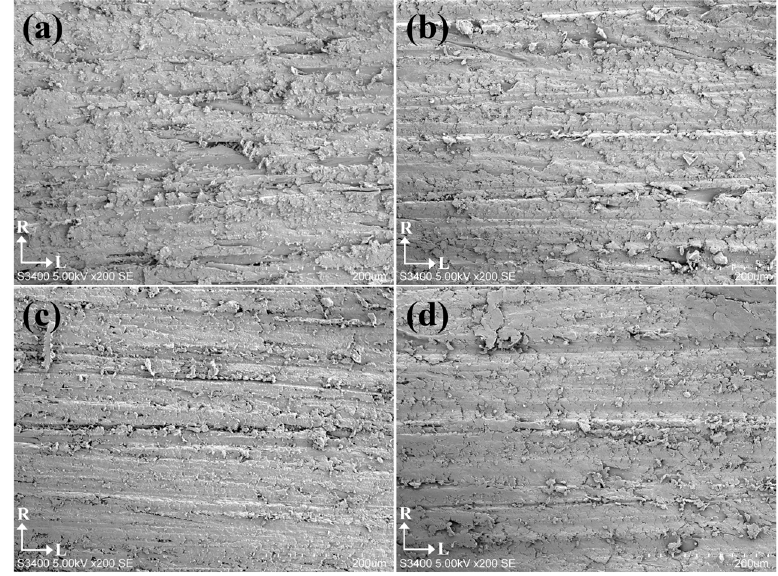
Figure 5. Surface micrographs of the sanded scrimbers with various densities: ( a ) 0.80, ( b ) 1.01, ( c ) 1.20 and ( d ) 1.39 g/cm 3 .